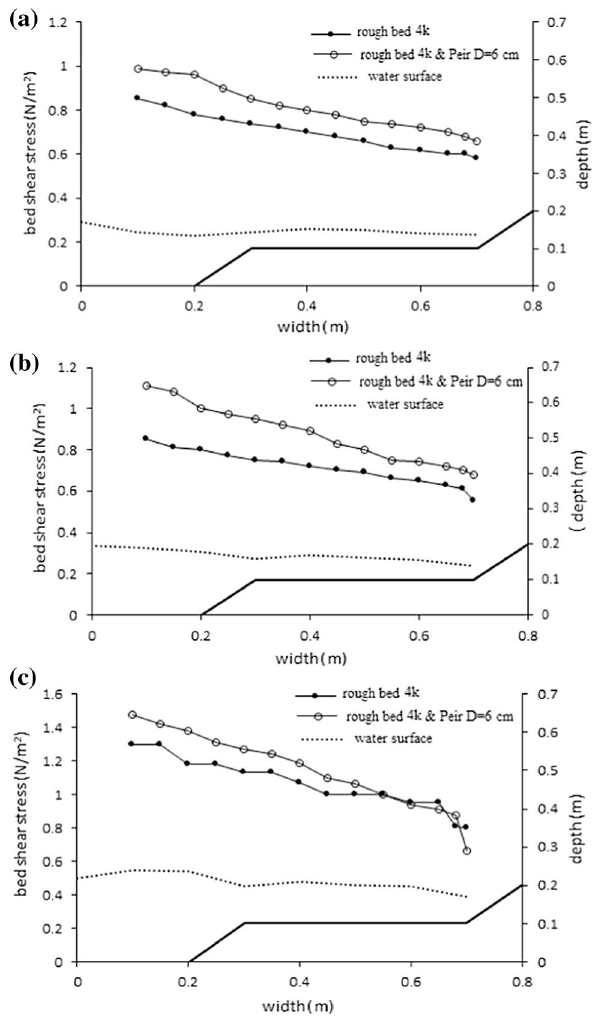
Fig. 10 Comparison of the bed shear stress in a roughened plain with the presence of a pier ( D = 6 cm) and roughened plain (distances of 4 k) a Q 1 , b Q 2 and c Q